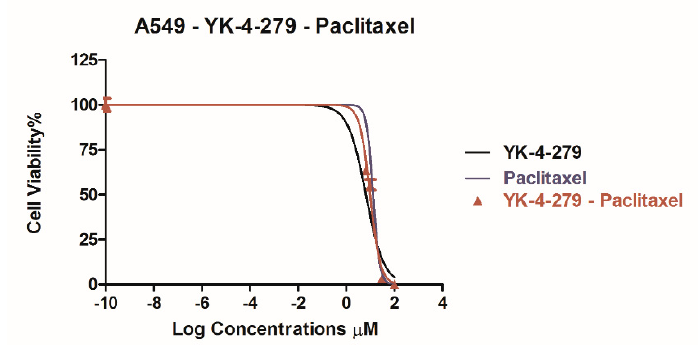
Figure 2. Combination graph of YK-4-279 and Paclitaxel (CI =